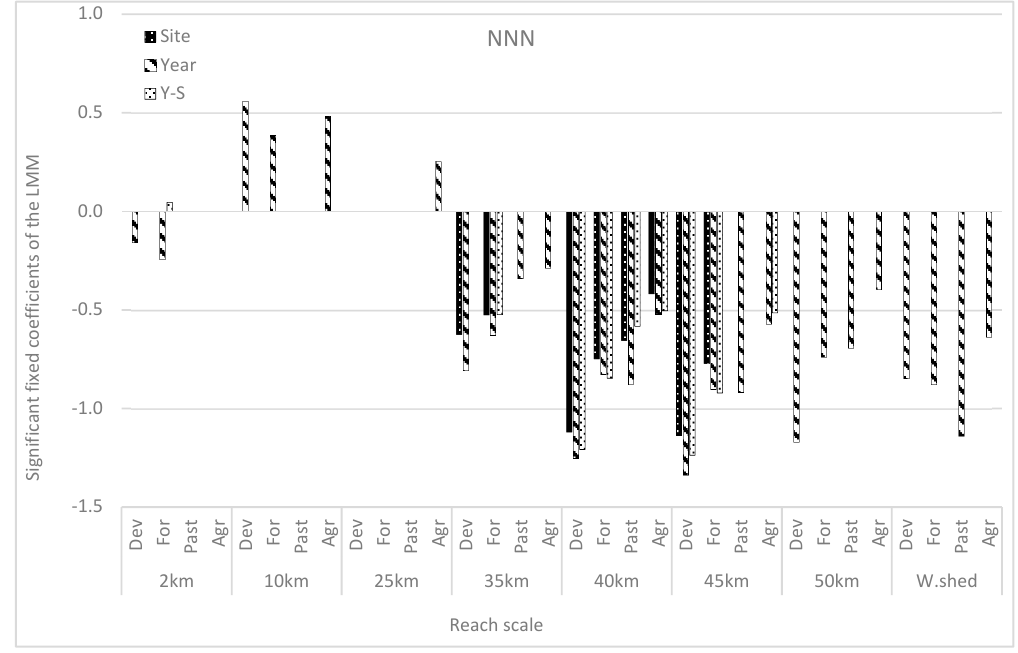
Figure 7. Significant coefficients (significance level = 0.1) in the mixed effect models describing the associations between land use and water quality for Total Nitrogen.